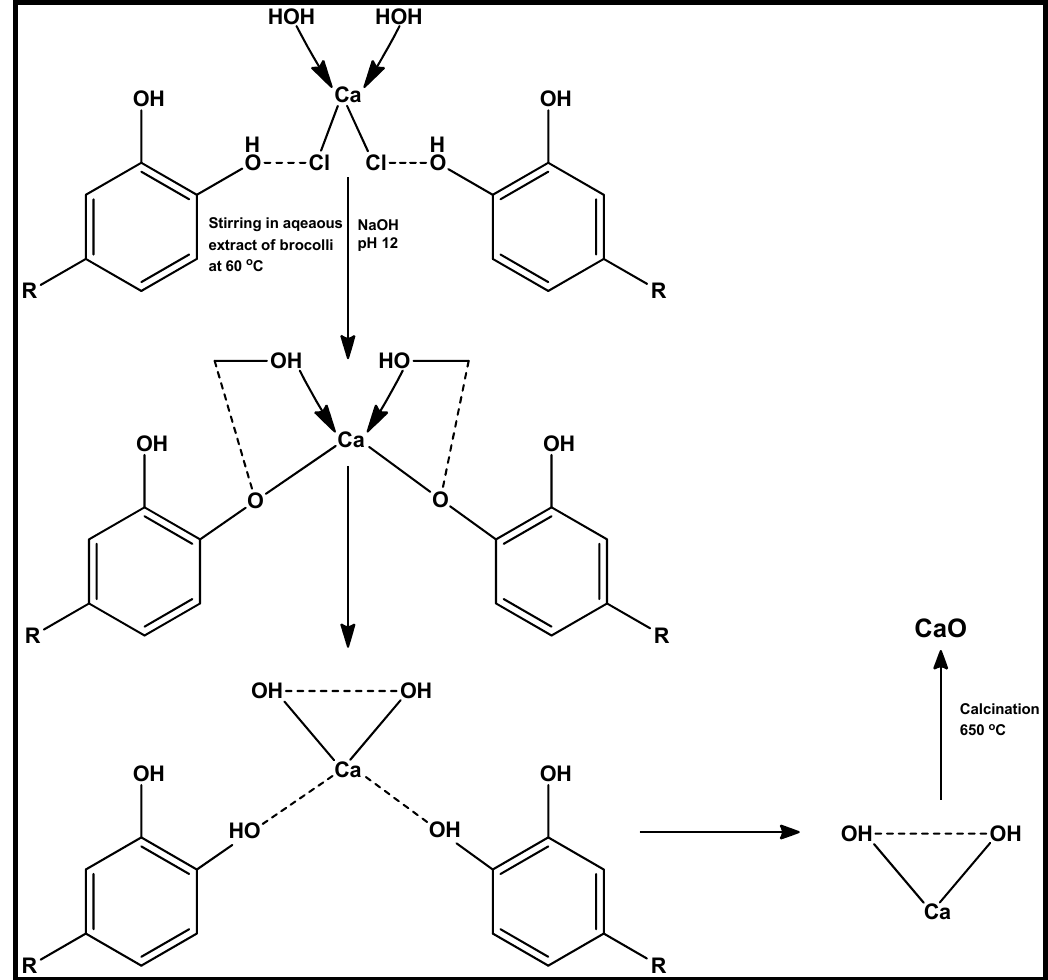
Figure 6. Suggested mechanism of the synthesis of CaO nanoparticles mediated using aqueous broc ‐ coli extract. Redrawn from [84], with permission from John Wiley and Sons (Copyright 2022).